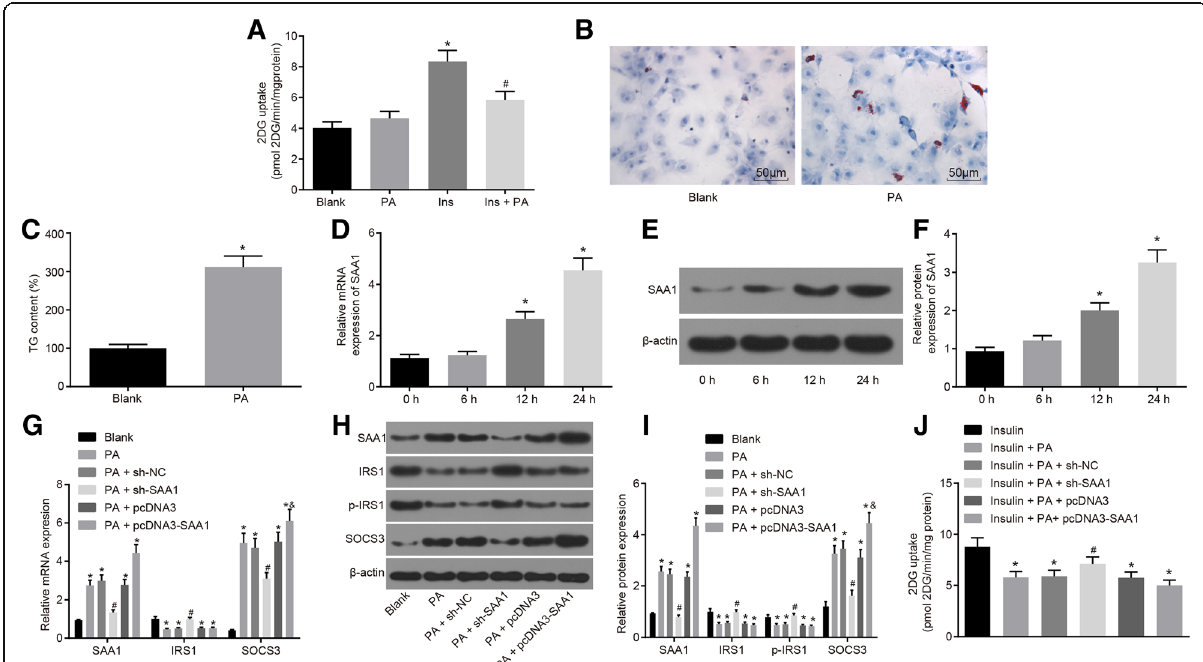
Fig. 2 The insulin resistance in Huh7 cells is suppressed by silencing of SAA1. a , insulin-stimulated 2DG uptake in response to the treatment of PA, insulin and insulin + PA; *, p < 0.05 vs. the blank group; #, p < 0.05 vs. the insulin group; b , Huh7 cell images after PA treatment by oil red O staining (×200); c , the contents of triglycerides after PA treatment; d , the mRNA expression of SAA1 in PA-treated Huh7 cells according to RT-qPCR; *, p <0.05 vs. the 0-h group; e , the gray value of SAA1 and β -actin protein bands measured by western blot analysis; f , the protein expression of SAA1 in PA-treated Huh7 cells according to western blot analysis; *, p < 0.05 vs. the 0-h group; g , the mRNA expression of SAA1, IRS1 and SOCS3 in response to the treatment of PA +sh-SAA1, PA+pcDNA3, PA+pcDNA3-SAA1 tested by RT-qPCR; *, p <0.05 vs. the blank group; #, p <0.05 vs. the PA+sh-NC group; &, p <0.05 vs. the PA +pcDNA3 group; h , the gray value of SAA1, IRS1, SOCS3, and p-IRS1 protein bands evaluated by western blot analysis; i , the protein expression of SAA1, IRS1 and SOCS3, and the extent of IRS1 phosphorylation in response to the treatment of PA+sh-SAA1, PA + pcDNA3, PA + pcDNA3-SAA1 according to western blot analysis; *, p < 0.05 vs. the blank group; #, p < 0.05 vs. the PA + sh-NC group; &, p < 0.05 vs. the PA + pcDNA3 group; j , insulin-stimulated 2DG uptake in response to the treatment of insulin + PA + sh-SAA1, insulin + PA + pcDNA3, insulin + PA + pcDNA3-SAA1; *, p < 0.05 vs. the insulin group; #, p < 0.05 vs. the insulin + PA + sh-NC group; data were expressed by means ± standard deviation; differences between two groups were compared by the t test; multiple groups were compared by one-way analysis of variance; the experiment was repeated 3 times; SAA1, serum amyloid A protein 1; 2DG, [ 3 H]2-deoxyglucose uptake; PA, palmitate; RT-qPCR, reverse transcription quantitative polymerase chain reaction; SOCS3, suppressor of cytokine signaling 3; IRS1, insulin receptor substrate 1; p-IRS1, phosphorylation level of IRS1; NC, negative